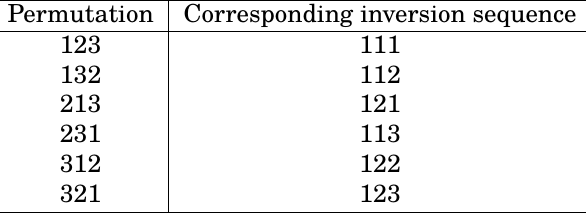
Table 1: Inversion sequences of the six permutations of { 1,2,3 }